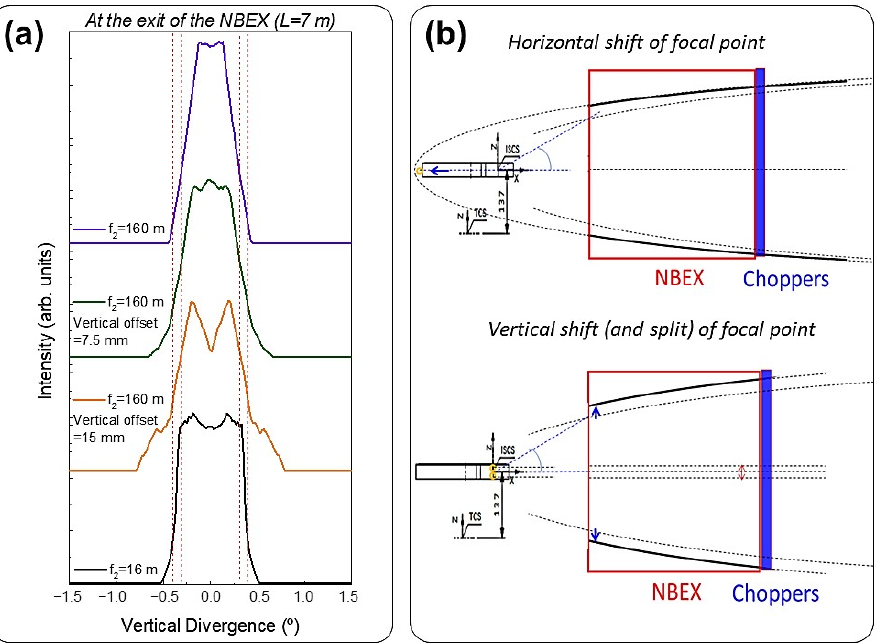
Figure 3. ( a ) Vertical divergence distributions considering the vertical design options described in the text; ( b ) Schematic layout of the options considered for the vertical profile of the NBEX, which included a horizontal shift of the focal point ( yellow dot ) upstream to the cold source ( top image ), and a vertical shift and split of the focal point ( yellow dots, bottom image ).